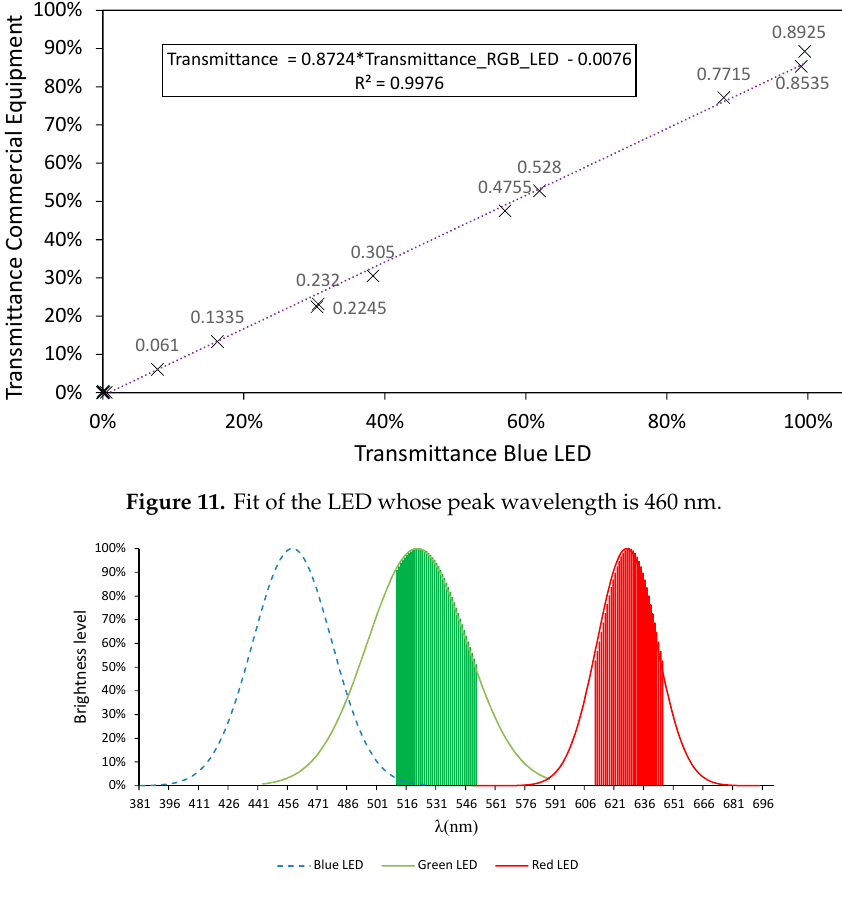
Figure 12. Useful emission spectrum of the RGB-LED.